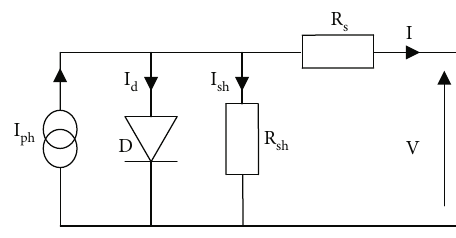
Figure 1: Single-diode con fi